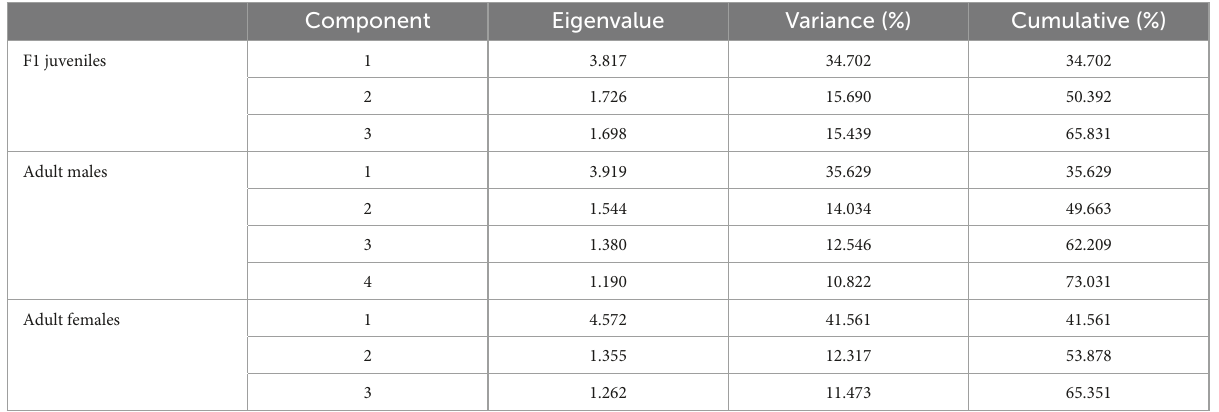
TABLE 5 The total variance explained for the offspring